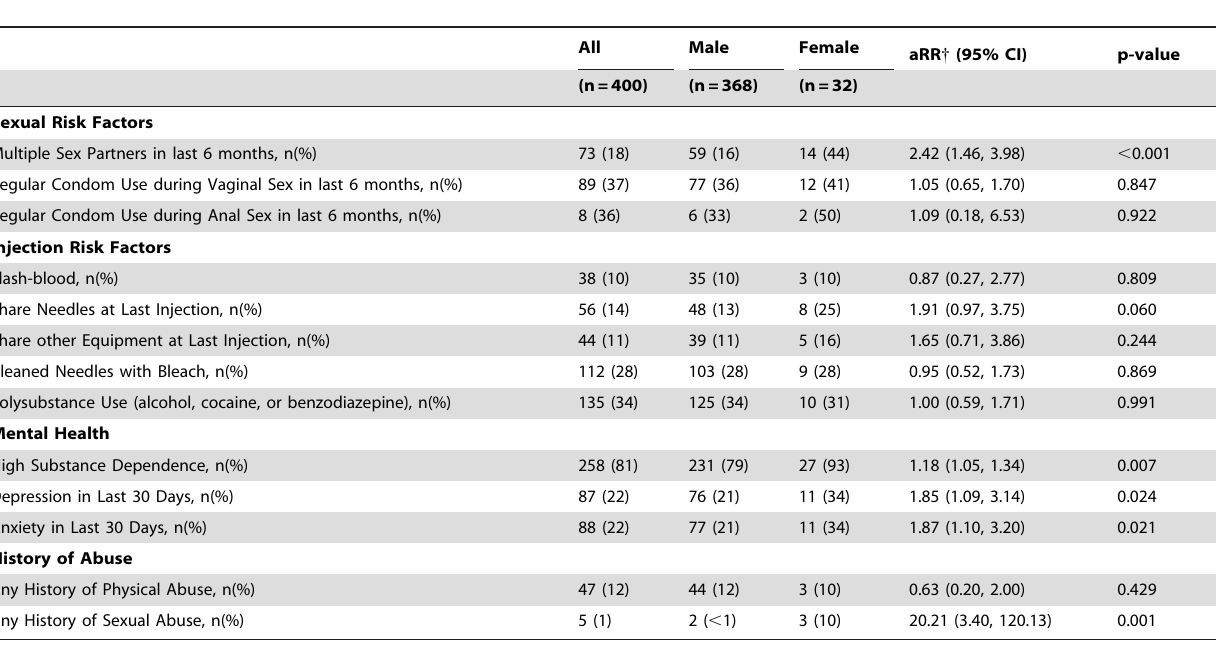
Table 3. HIV Risk, Mental Health and History of Abuse between Male and Female MAT clients.